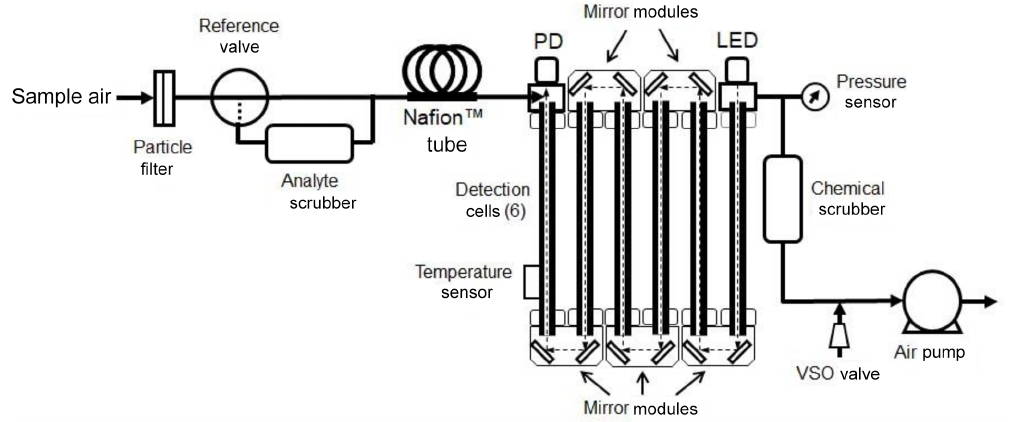
Figure 1. Schematic diagram of a folded tubular photometer for measuring the concentrations of gas-phase species such as O 3 , NO 2 , and SO 2 and particulates such as black carbon, based on the absorbance of UV (O 3 , SO 2 ), visible (NO 2 , black carbon), or infrared (black carbon)